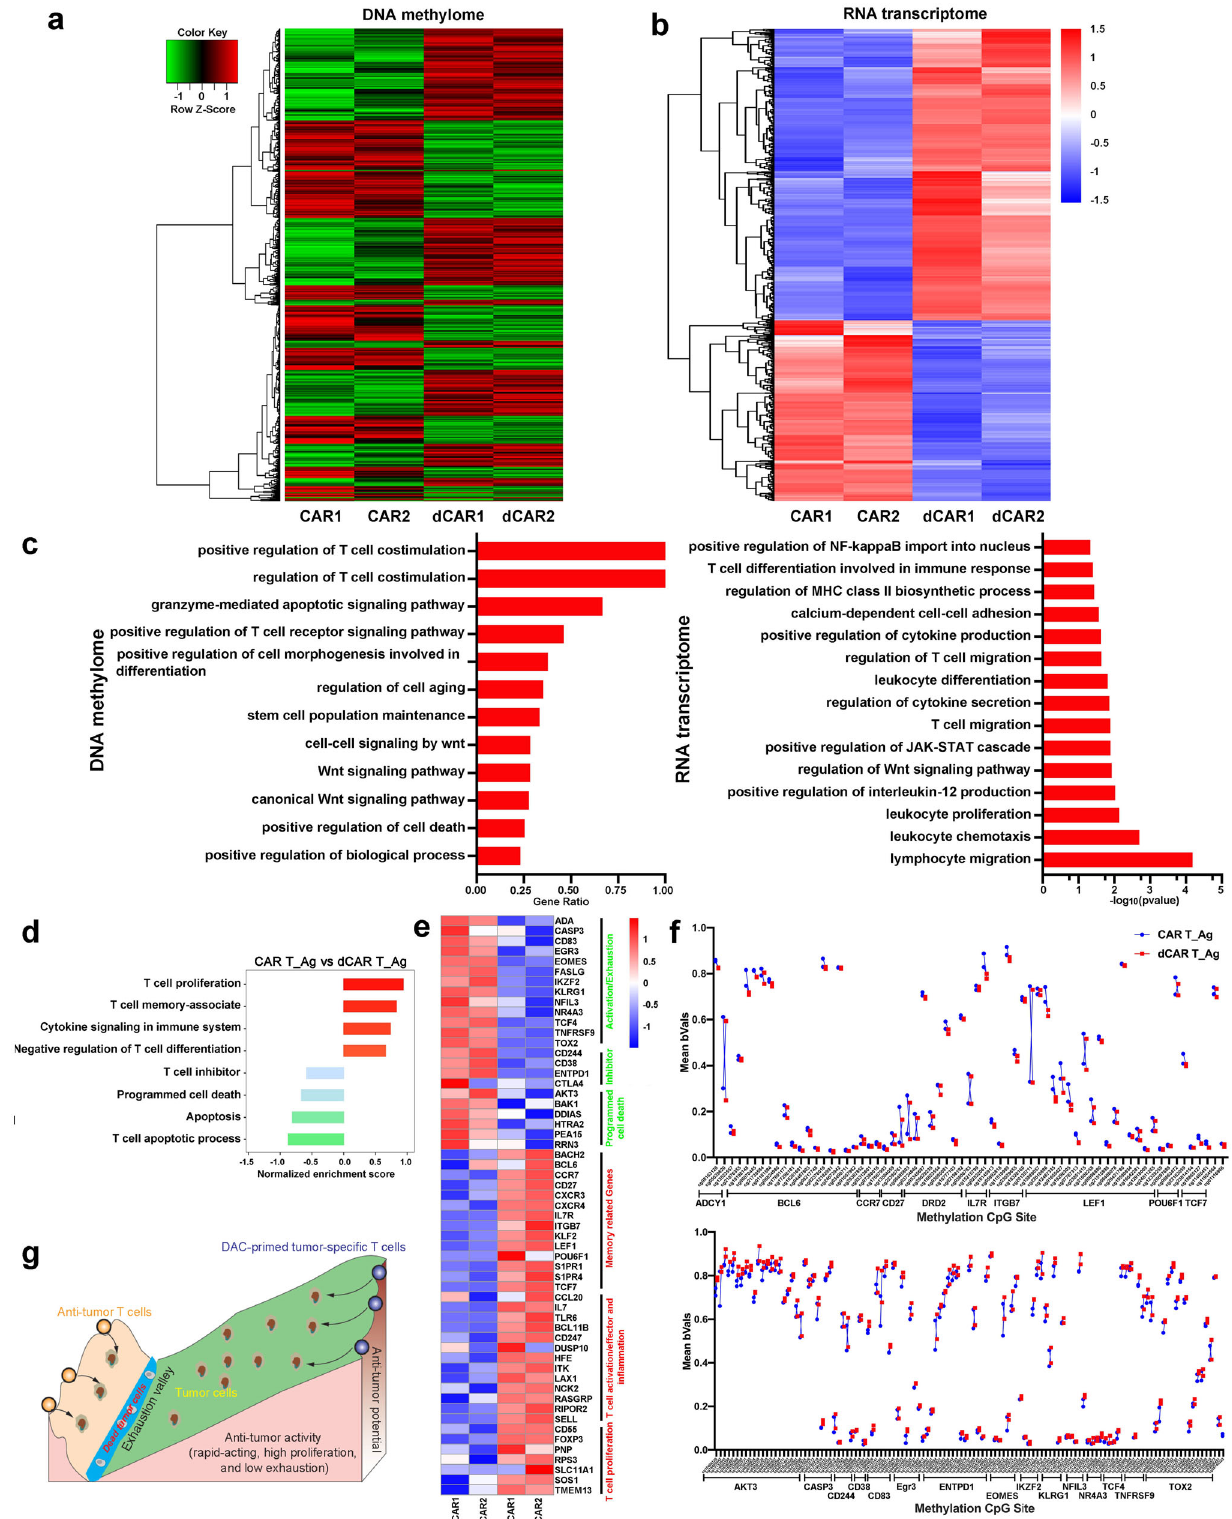
the CAR T cells after 14 days of cell infusion; in contrast, the tumour-in fi ltrating dCAR T cells showed stable in cytokine- produced function. These data suggested that the tumour- in fi ltrating CAR T cells were in a relatively dysfunctional state relative to the tumour-in fi ltrating dCAR T cells after cell infusion. To con fi rm that these gene transcriptome changes were due